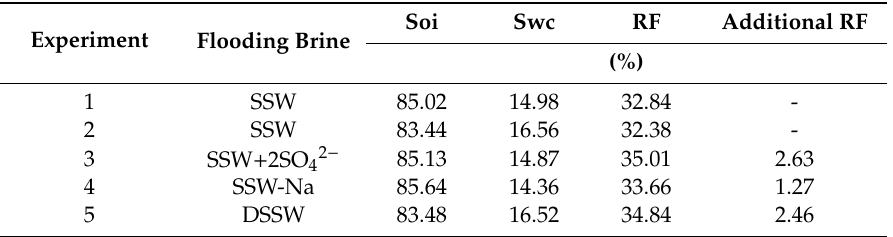
Figure 9. Oil recovery and pressure drop versus PV injected for artificial structure oil-wet micromodel. Four injection brines of Table 2 are flooded as the secondary mode. Table 9. Summary of artificial structure oil-wet micromodel with initial oil saturation, connate water saturation and final oil recovery